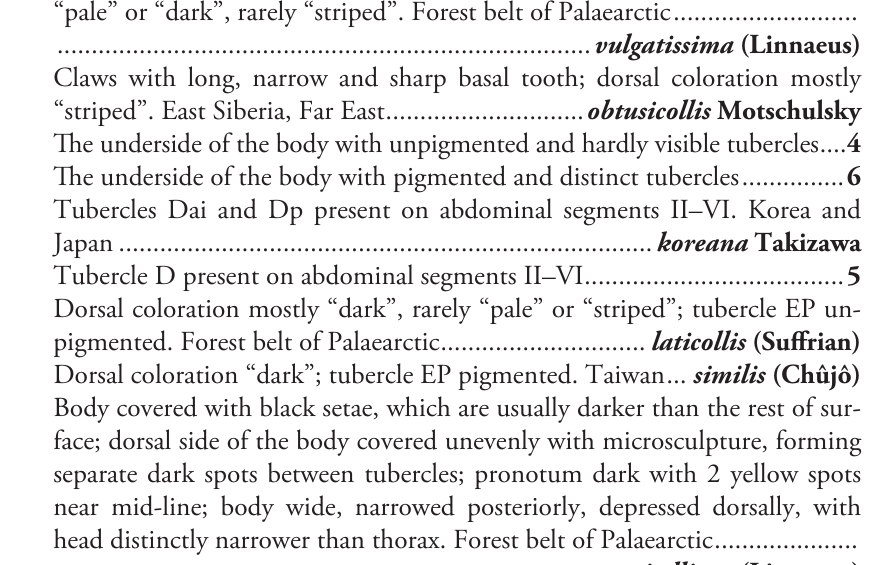
Body covered with pale setae, which are usually not darker than the rest of surface, or setae paler than the rest of surface; dorsal side of the body cov- ered with dense and even microsculpture, not forming separate spots; dorsal side giving dark impression; body elongate, cylindrical, with head indistinctly Pronotum black with narrow pale medial stripe. Central Europe, European